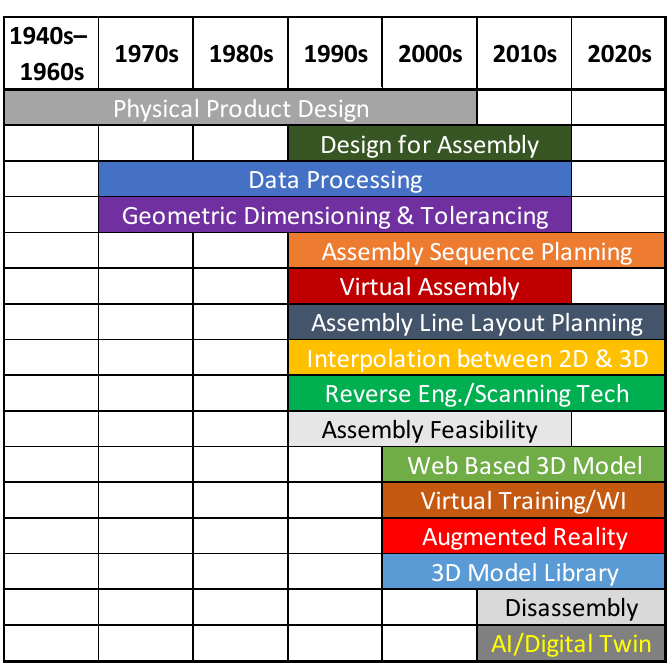
Figure 3. Three-dimensional (3D) product model research themes evolution over time.